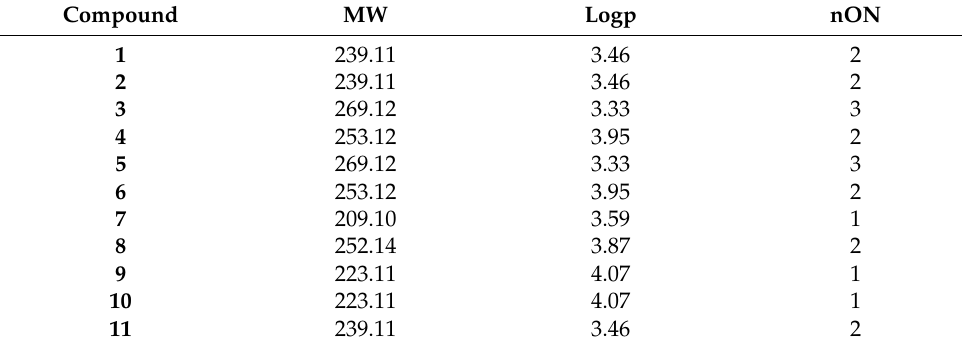
Table 1. MW, logp, and nON of compounds 1 – 11